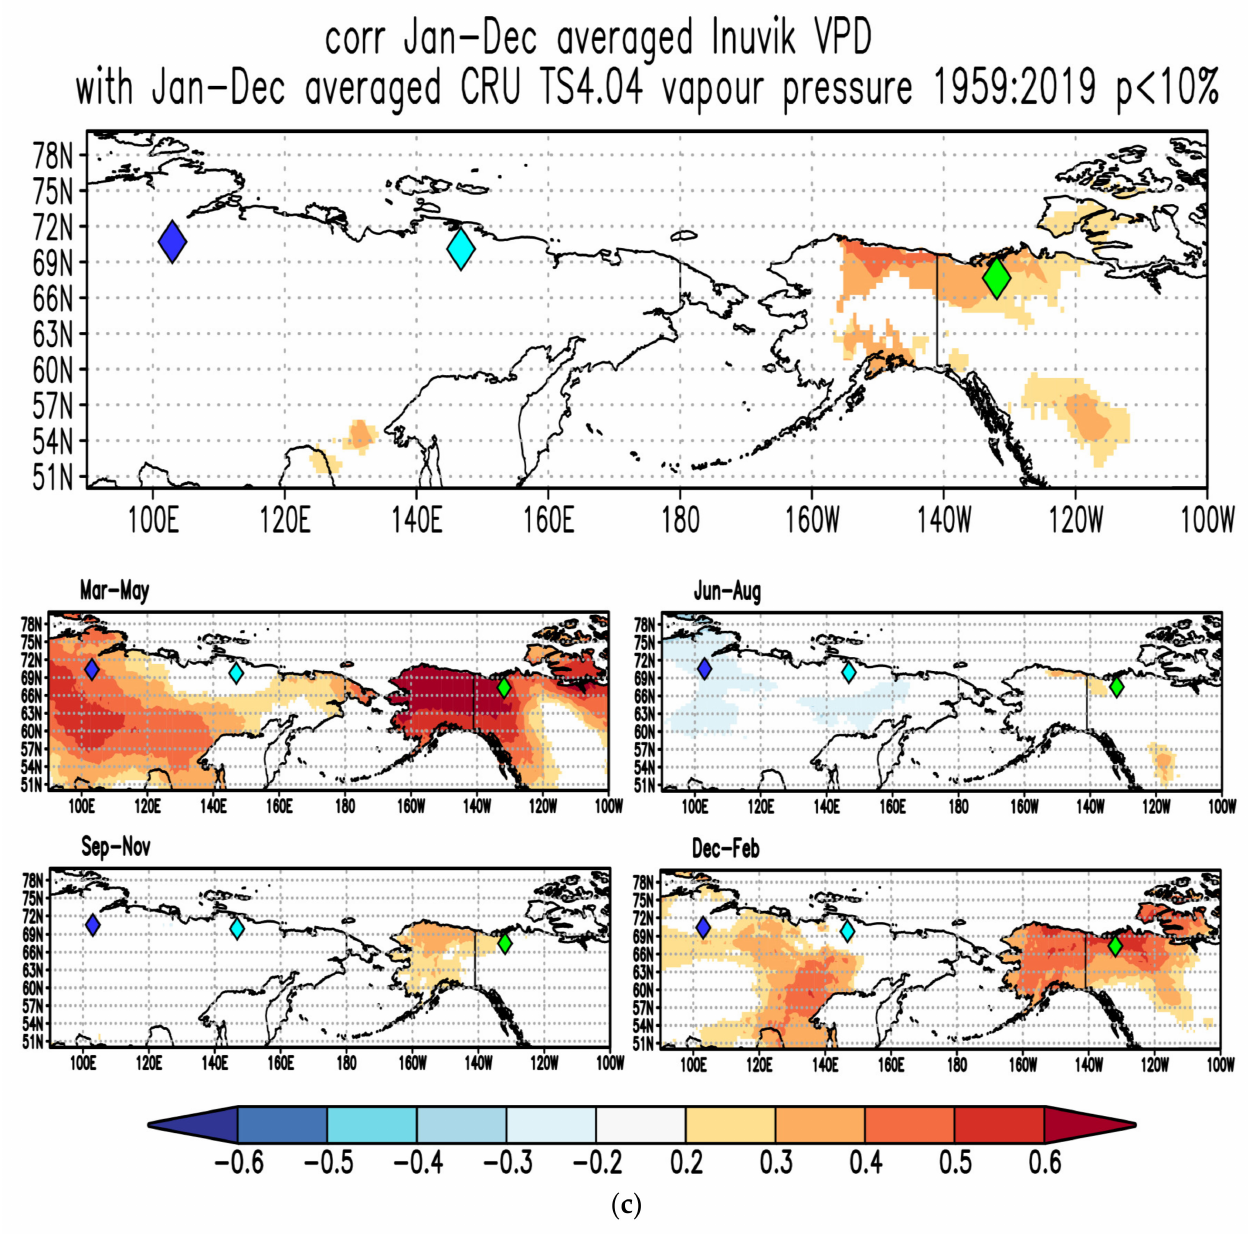
Figure 6. Spatial distribution of correlation coefficients between gridded (51 ◦ N–78 ◦ N 90 ◦ E–100 ◦ W) and local annual (January-December), spring (March-April-May), summer (June-July-August), autumn (September-October-November) and winter (December-January-February) vapor pressure deficit (VPD) data for ( a ) Chokurdakh, northeastern Yakutia (YAK), ( b ) Khatanga, eastern Taimyr (TAY), and ( c ) the Mackenzie Delta, Canada (CAN) for the period from 1959 to 2019. Negative significant correlation coefficients are marked in dark blue (r ≥ − 0.6; p < 0.01), while positive significant correlations are highlighted in red (r ≥ 0.6, p <